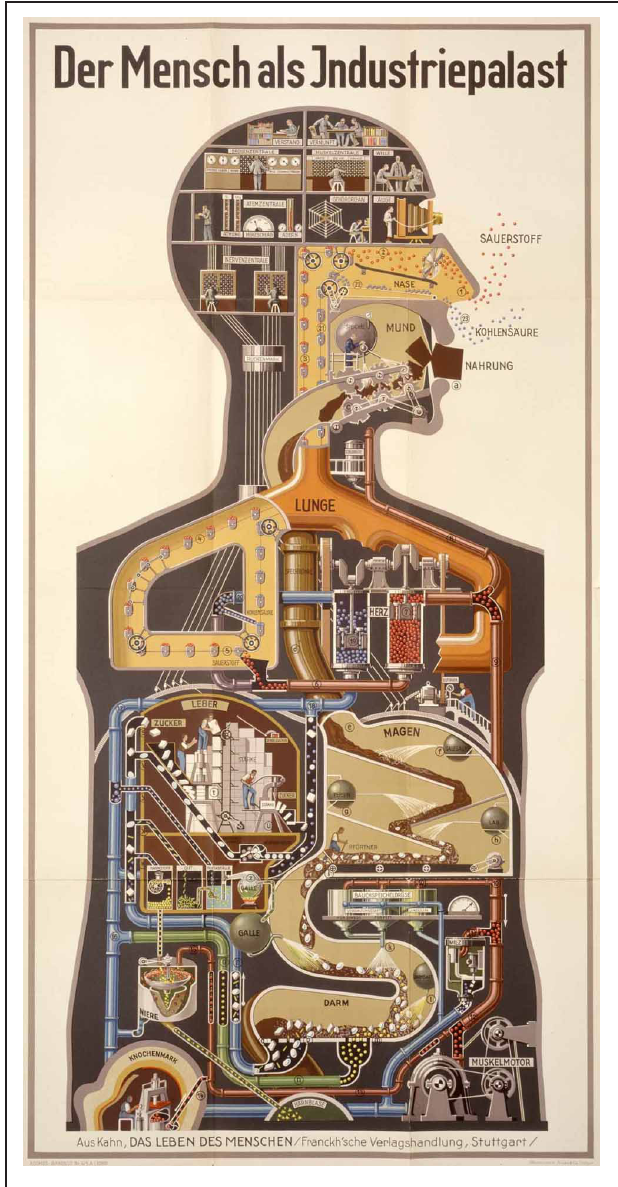
FIGURE 1 | Der Mensch als Industriepalast (Man as Industrial Palace) (1926). From Fritz Kahn (1888–1968). Chromolithograph. National Library of Medicine,